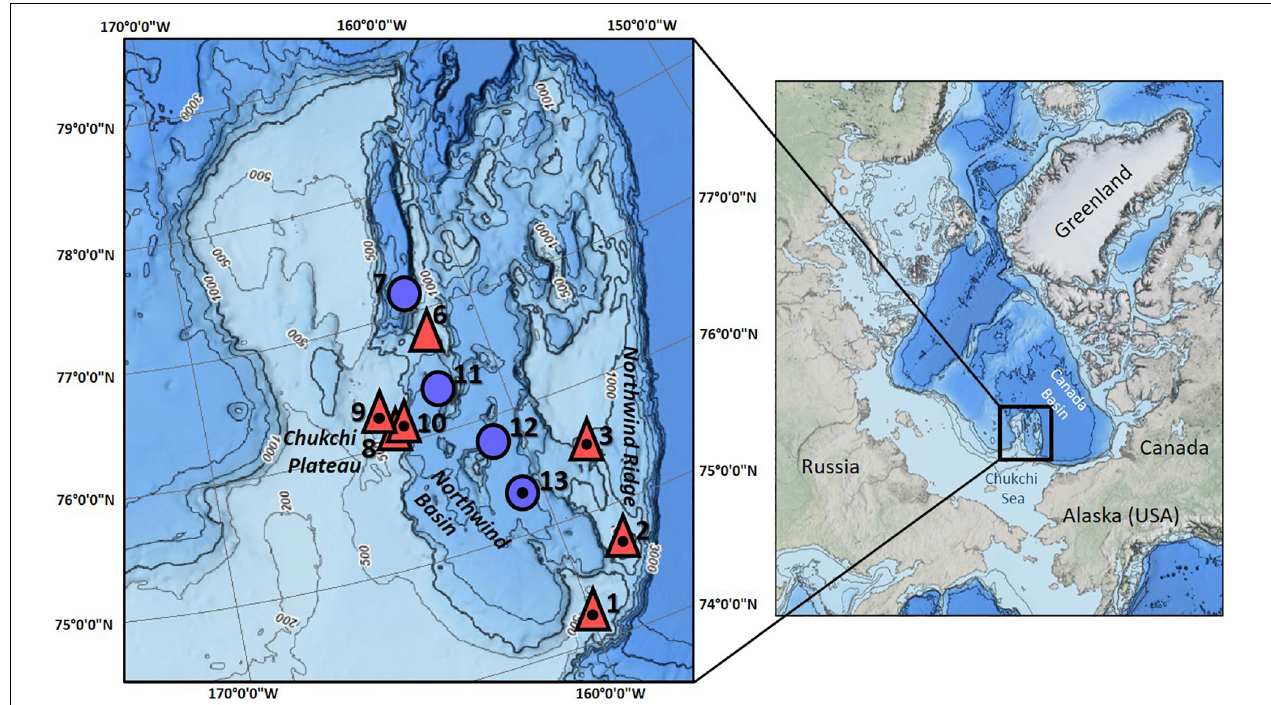
FIGURE 1 | Study area and stations sampled in the Arctic Chukchi Borderland. Red triangles are mid-depth stations, blue circles are deep stations; numbers in bold print are station numbers; small numbers along isobaths indicate water depth. All stations were sampled by ROV, except station 3. Stations that were additionally sampled by trawl are indicated by a dot inside of the